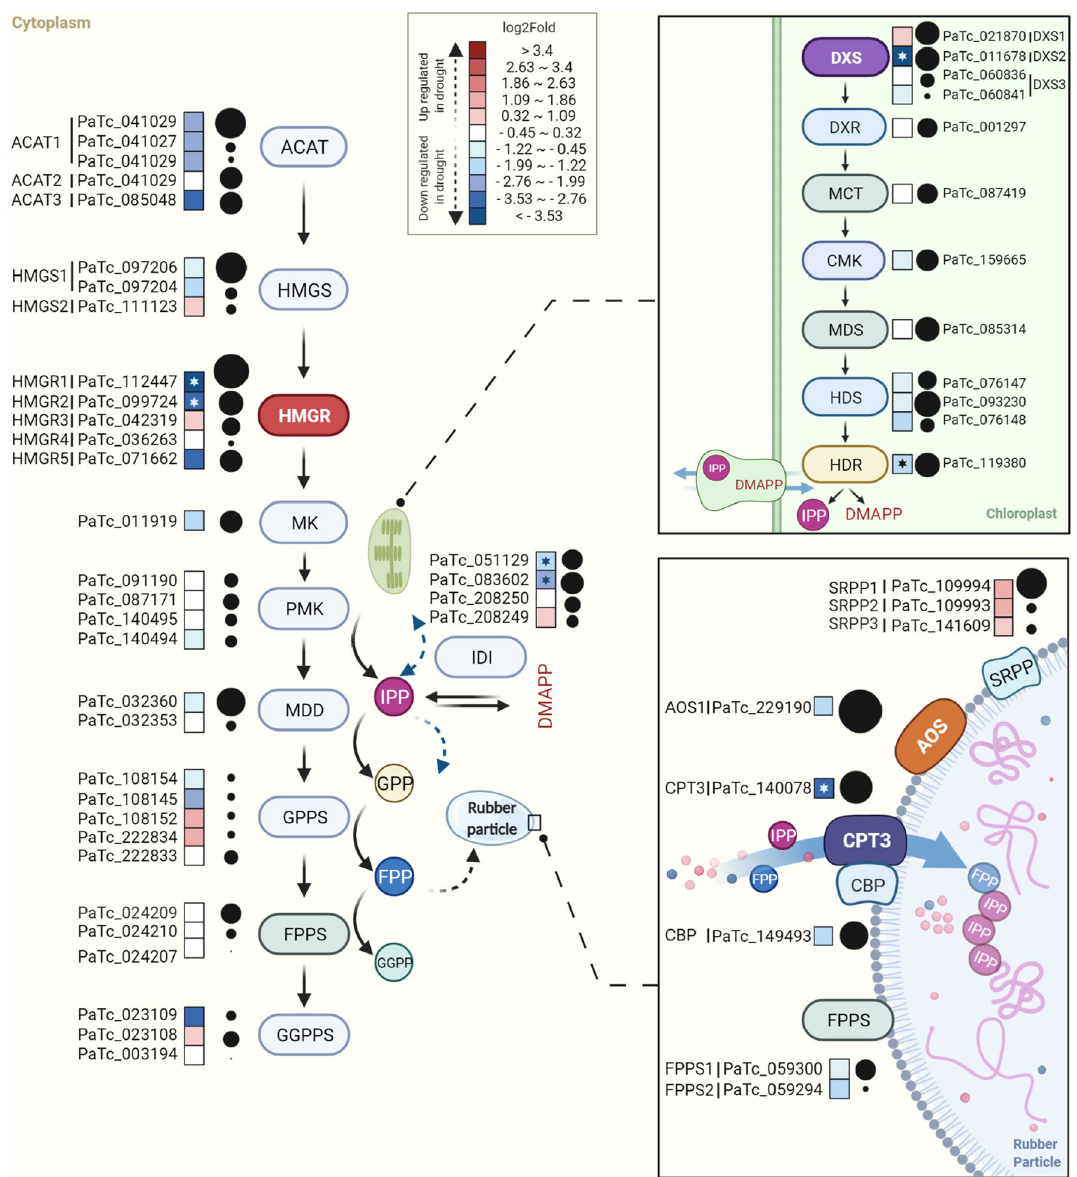
Figure 5. Expression of transcripts involved in mevalonate pathway (MVA), methylerythritol phosphate pathways (MEP) and rubber particle associated genes. Lower right, schematic model of the rubber biosynthetic machinery. Relative differential expression showed by a color gradient from low (blue) to high (red). Asterisks indicate significant differential expression (FDR < 0.05 and log2 fold-change > 2). Black dot sizes proportional to the expression